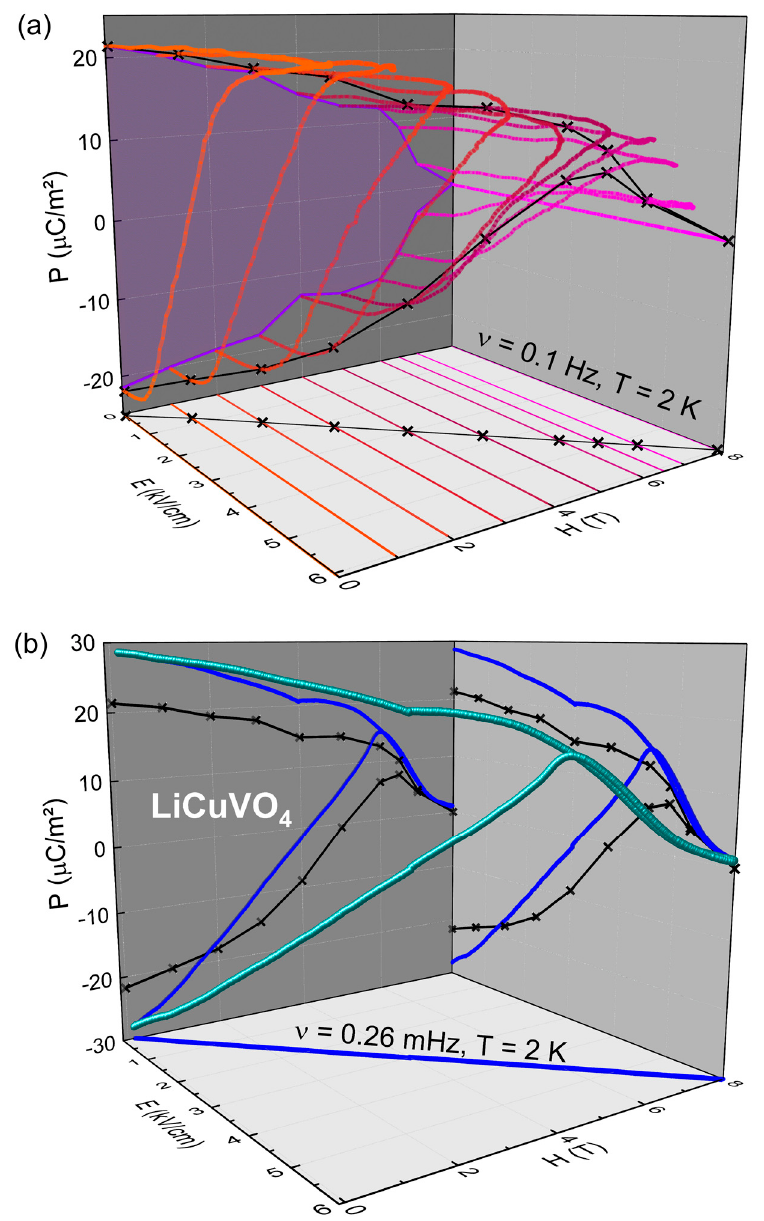
Figure 4. ( a ) P ( E ) loops of a LiCuVO 4 single crystal, which are the same as shown in Figure 3. The color-coded lines (orange to magenta) represent the positive half of the hysteresis loops at static magnetic field. The crosses depict the intersection with the bisecting line in the E , H -plane. The P -values of these intersections forms a multiferroic hysteresis loop derived in static magnetic fields (shown also in ( b )); ( b ) Multiferroic hysteresis loop of a LiCuVO 4 single crystal measured at T = 2 K and 0.26 mHz, again with P along the a direction and magnetic fields along the c direction. The dark-blue lines are projections of the multiferroic hysteresis loop in P ( E ), P ( H ) and within H , E planes.